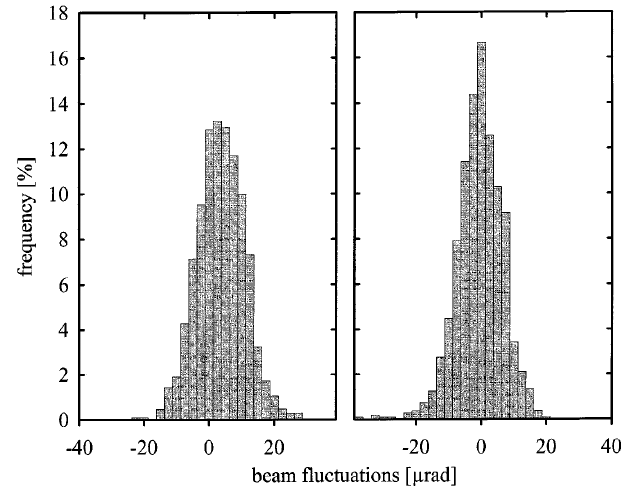
Fig. 7. The frequency distribution of the residual fluctuations in laser beam directions while the control loop is in operation ( left panel : horizontal axis; right panel : vertical axis). The residual fluctuations of the laser beam remain within (cid:139)10 l rad for more than 81% of the time in horizontal and for more than 85% of the time in the vertical axis. Nearly all laser pulses remain within (cid:139)20 l rad for